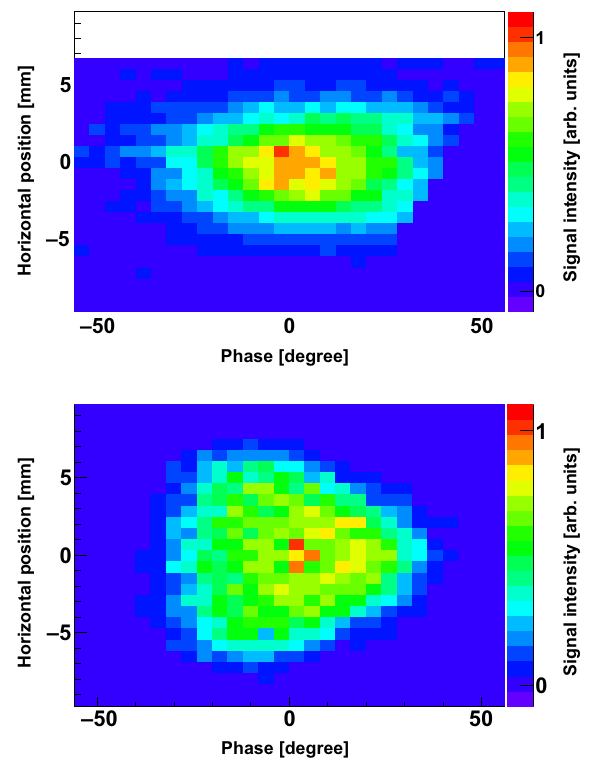
FIG. 13. Measured ϕ − x correlation (top) and simulated one (bottom). The size of the HOPG target was 0 . 2 × 1 . 0 mm 2 . The blank region in measurement results was due to a limited BSM target actuator